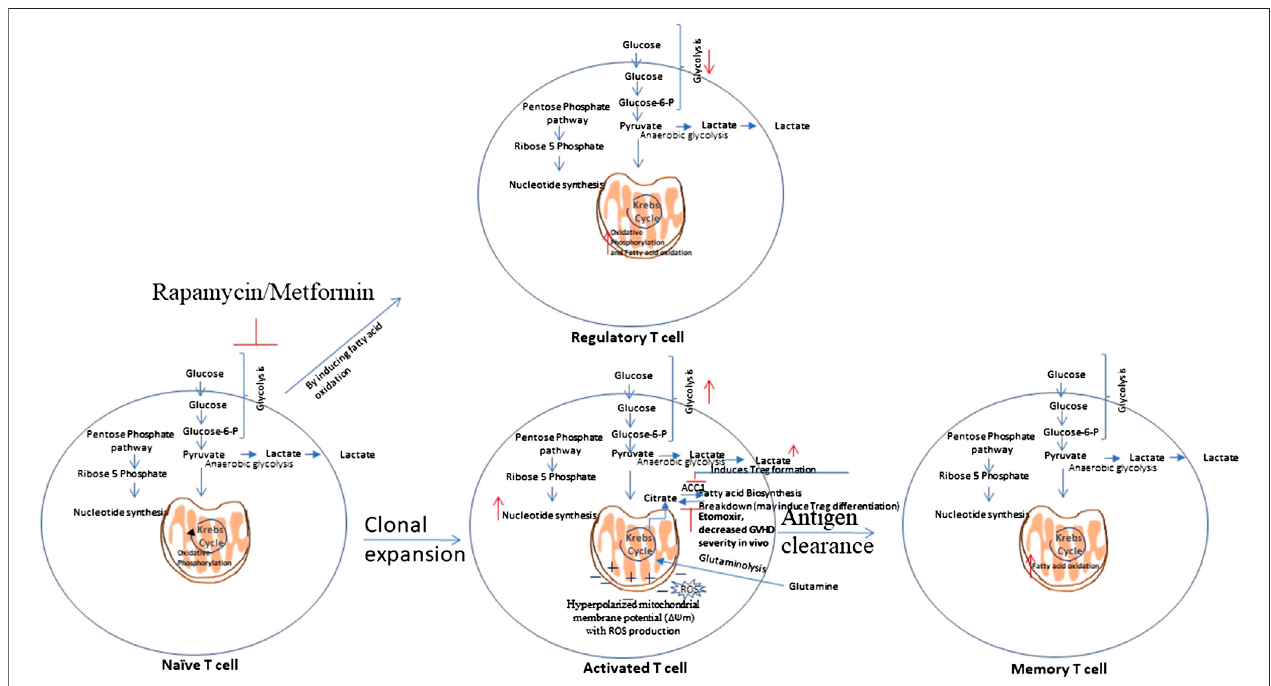
FIGURE 3 | T cells metabolic reprogramming. Naïve T cells are highly dependent on Oxidative Phosphorylation (OXPHOS) and utilize catabolic metabolism which involves breaking down metabolites into smaller units that are either metabolized to produce energy or utilized in anabolic reactions. Upon antigen recognition, naïve TcellsdifferentiateintoTeffcellsandmostoftheseTeffcellsdieuponantigenclearance,butasubsetoflong-livedmemoryTcells(Tm)sustain.Teffcellsshowmetabolic shifttoglycolysisandshowincreasedpentosephosphatepathwayactivity.Teffcellstendtoutilizeglutamineinsteadofglucoseasamajorlipogenicprecursor.Teff cells show hyperpolarized mitochondrial membrane potential, with a simultaneous rise in the production of reactive oxygen species (ROS) that further mediate damage and in fl ammation. Tm cells show increased fatty acid oxidation. Rapamycin, which inhibits glycolysis, and Metformin which induces AMPK activity, that is involved in glycolysis inhibition, have shown to attenuate GVHD. This is mediated by enhanced fatty acid oxidation (FAO) in donor T cells which may reduce alloreactivity of T cells and enhance regulatory T cell (Treg)